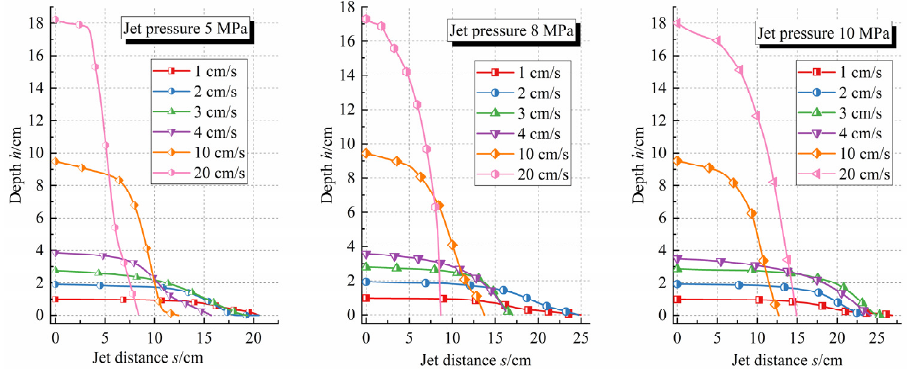
Figure 10. Erosion speed along the way.